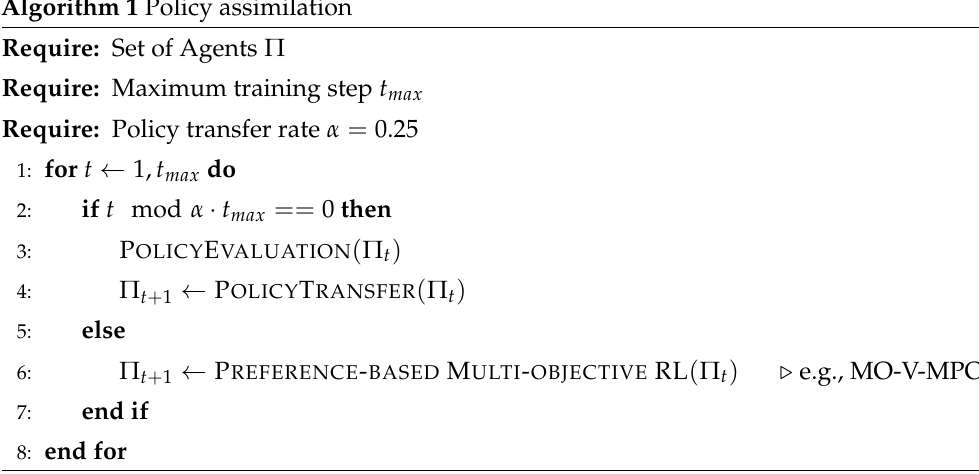
Figure 1. Graphical representation of the main processes in policy assimilation. ( a ) Policy Evaluation. ( b ) Policy Transfer. ( c ) Retraining. Algorithm 1 Policy